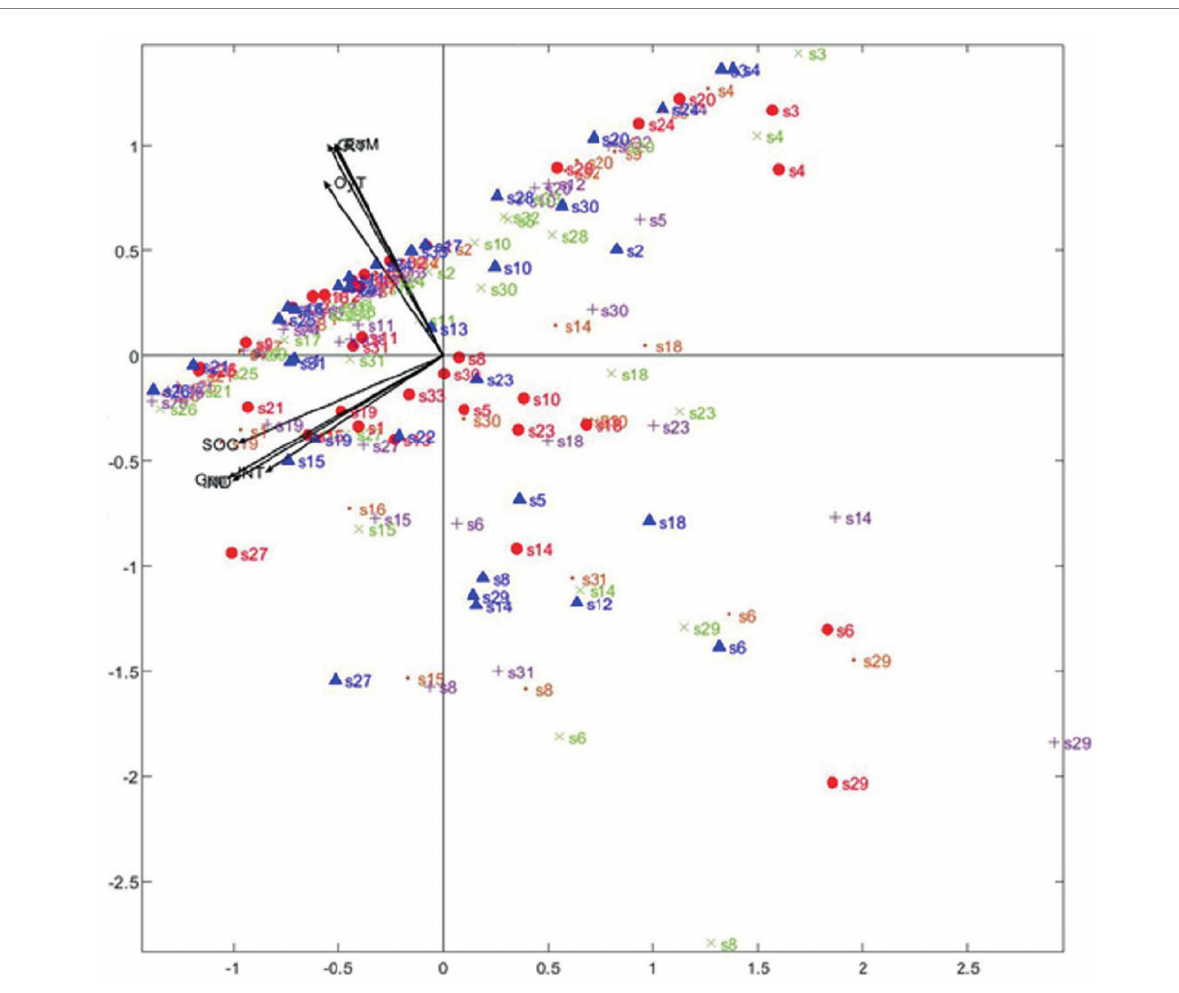
FIGURE 2 STATIS Dual Analysis. Vectors in the second quadrant: RT (Relationship with therapist), EoM (Approach or Method), OyT (Goals and Topics), and G (Overall alliance). Vectors in the third quadrant: IND (Individual well-being). INT (interpersonal functioning with family, and intimate relationships), SOC (satisfaction with work/school and relationships outside of home) and Gen (overall